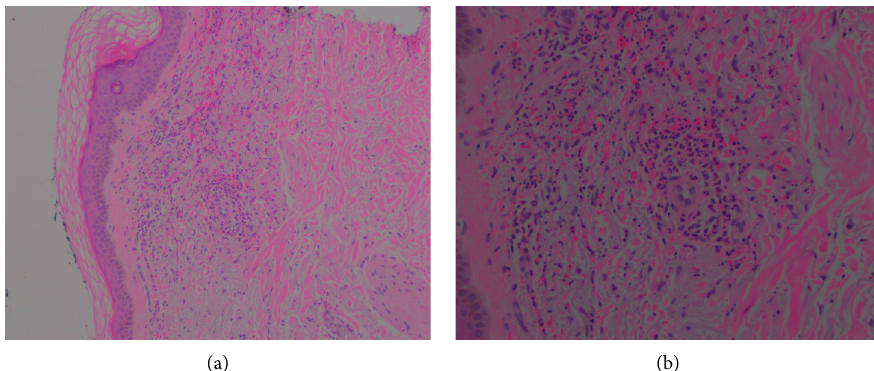
Figure 2: Excisional biopsy demonstrating superficial and deep perivascular neutrophil infiltration consistent with leukocytoclastic